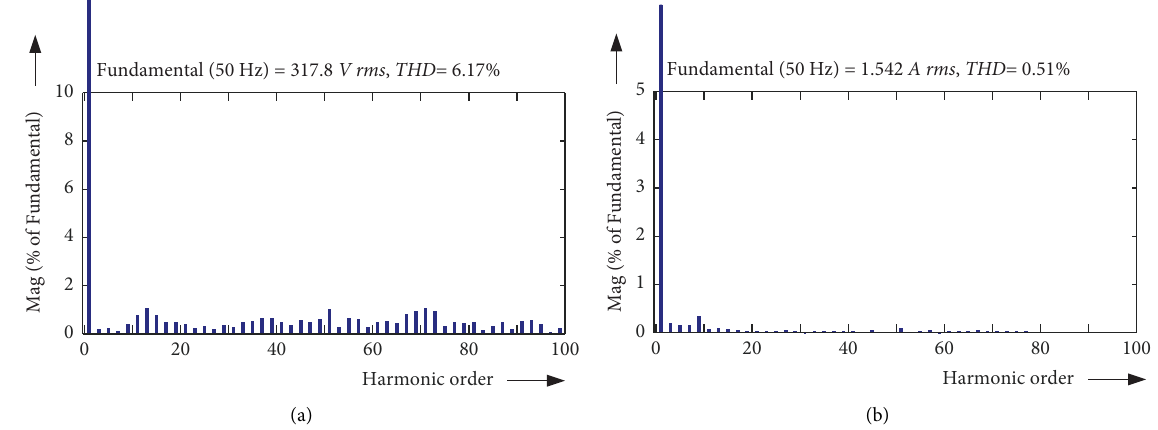
Figure 18: FFT spectra at M � 0.9 by using SVPWM-I technique. (a) Line Voltage. (b) Load Current.